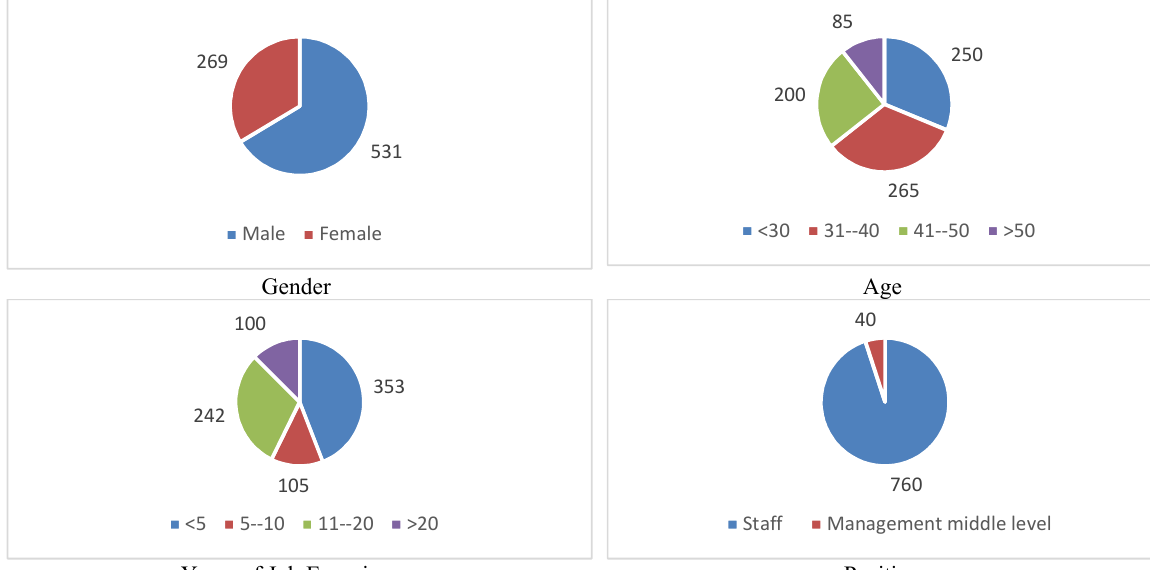
Fig. 2. Personal characteristics of the participants